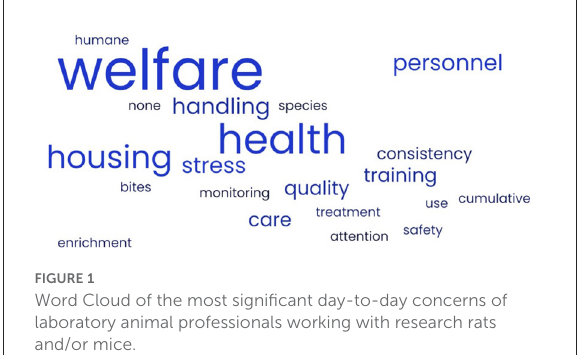
FIGURE2 Word Cloud of perceived barriers of laboratory animal professionals to implementing low stress handling techniques with research rats and